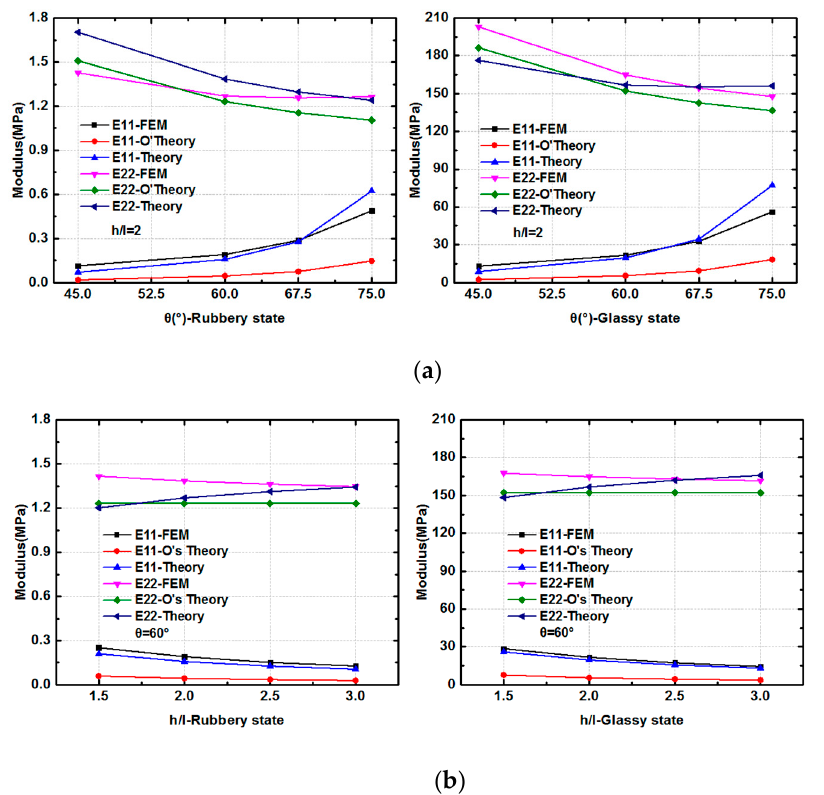
Figure 12. Sti ff ness of the unit cell in the x - and y -directions from two theoretical analyses and the FEM simulation (where E11 is the modulus in the x -direction, and E22 is the modulus in the y - direction): ( a ) Modulus at the rubbery state and glassy state with di ff erent θ ; ( b ) Modulus at the rubbery state and glassy state with di ff erent h l .